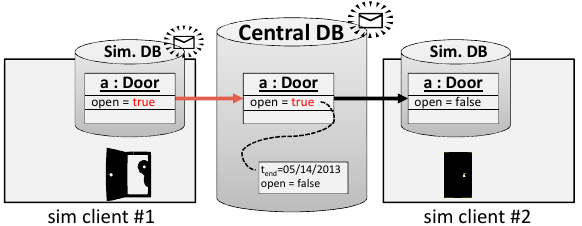
Figure 8. Example for DB-driven communication including